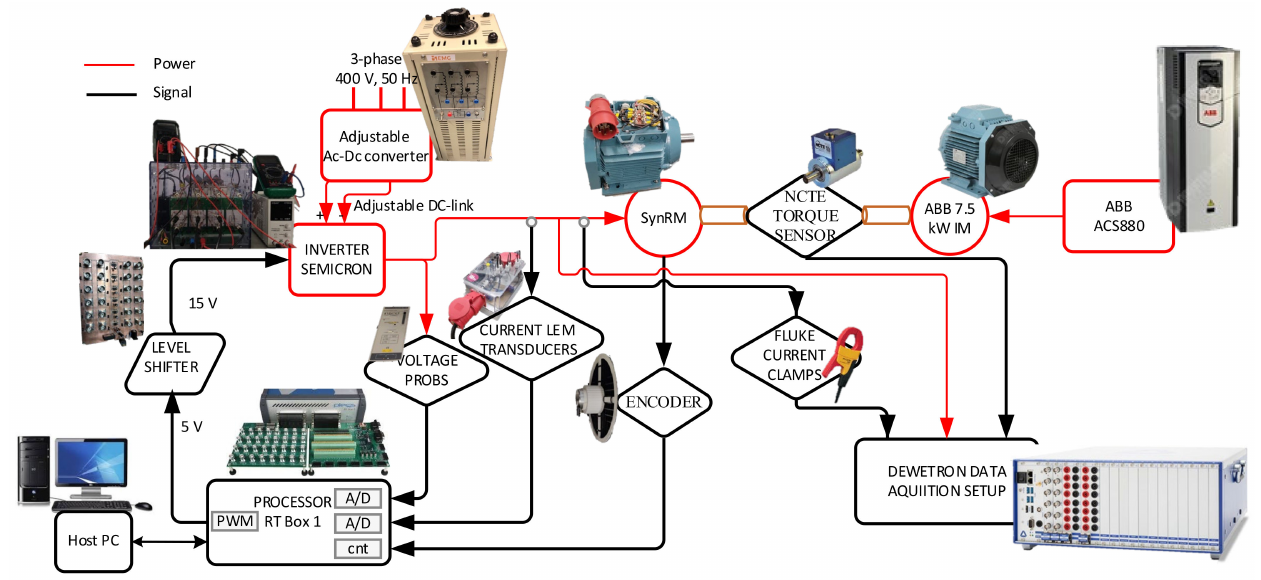
Figure 12. The integrated research laboratory setup block